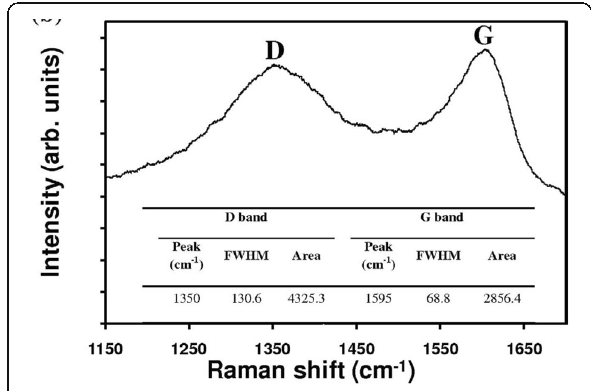
Fig. 9 Raman spectra of mangosteen peel carbon